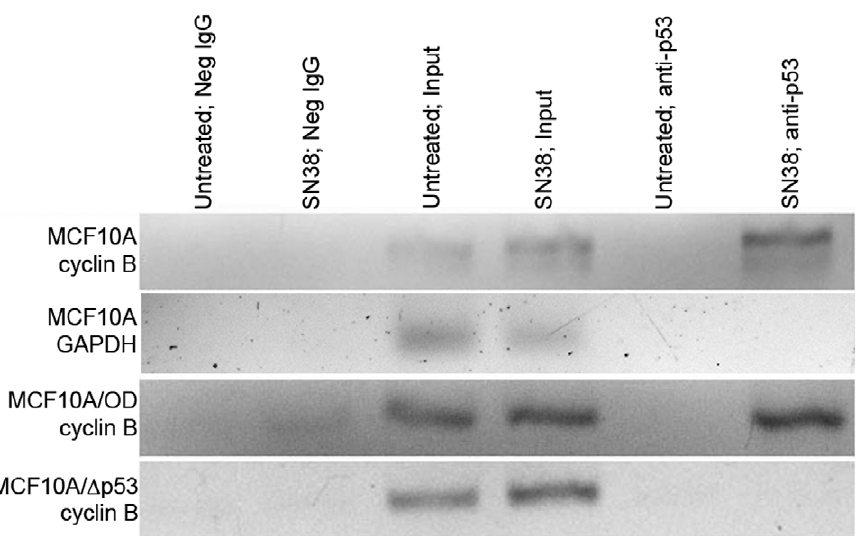
Figure 5. Analysis of p53 binding to head-to-tail response element using chromatin immunoprecipitation assays. MCF10A, MCF10A/ OD, and MCF10A/ D p53 cells were incubated with either fresh media (untreated) or 10 ng/ml SN38 for 24 hours, followed by cross-linking in 1% formaldehyde. Chromatin was then purified, sonicated, and immunoprecipitated with anti-p53 antibody or negative IgG antibody. Unprecipitated chromatin was used as a positive control (input). DNA was isolated and amplified by PCR using primers flanking the head-to-tail response element in the cyclin B promoter or the RNA Polymerase II binding site from the GAPDH promoter. The amplified PCR fragments were analyzed by agarose gel electrophoresis.